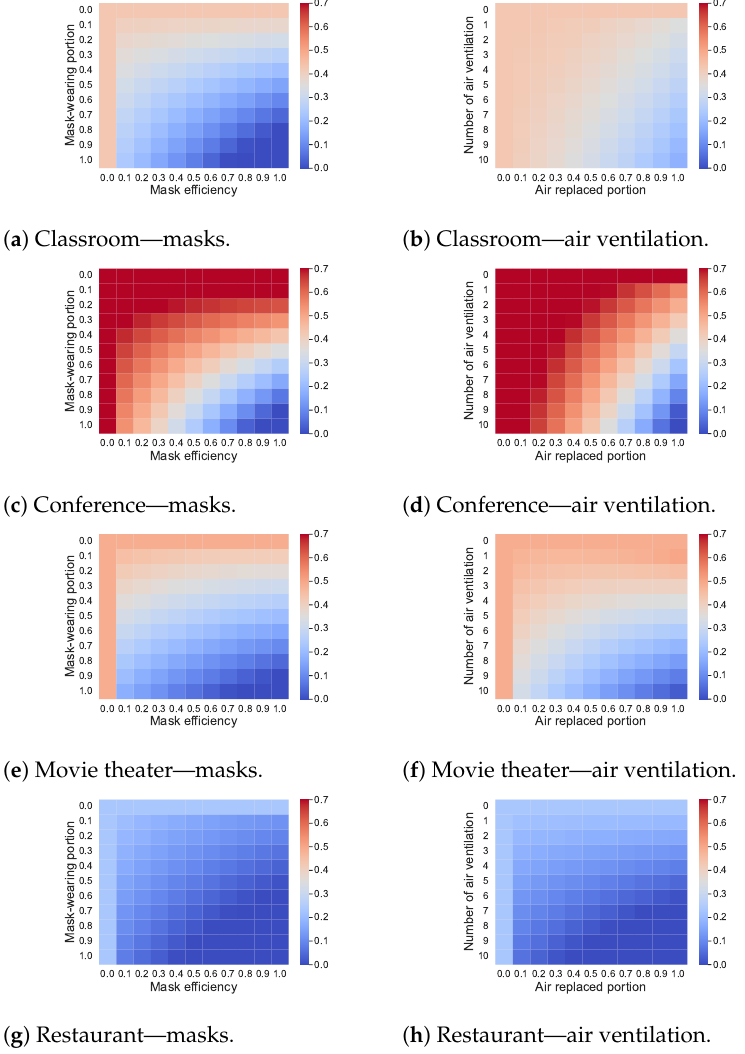
Figure 5. The influence of mask-wearing and air-ventilation PIPs on the number of infected individu- als over a period of 90 min (an h and a half). The results are shown as the average value of all the rooms from the same